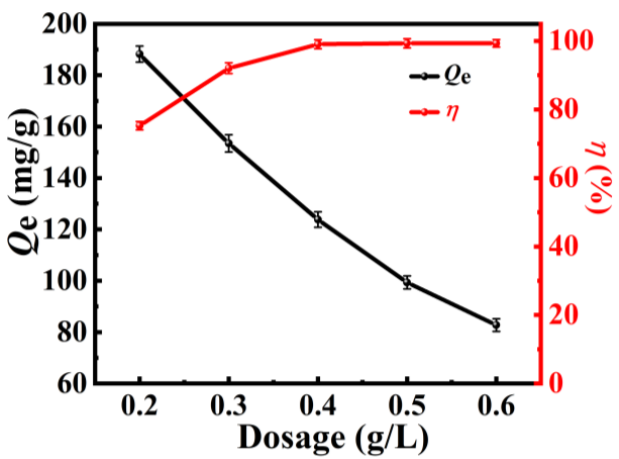
Figure 4. Effect of adsorbent dosage on the defluoridation performance of LMF11 NFs.